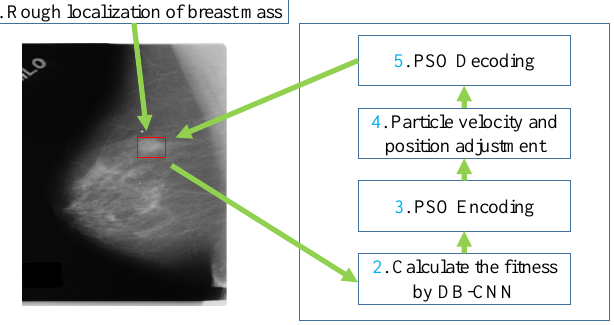
Figure 5. Flow chart of breast mass bounding box regression using